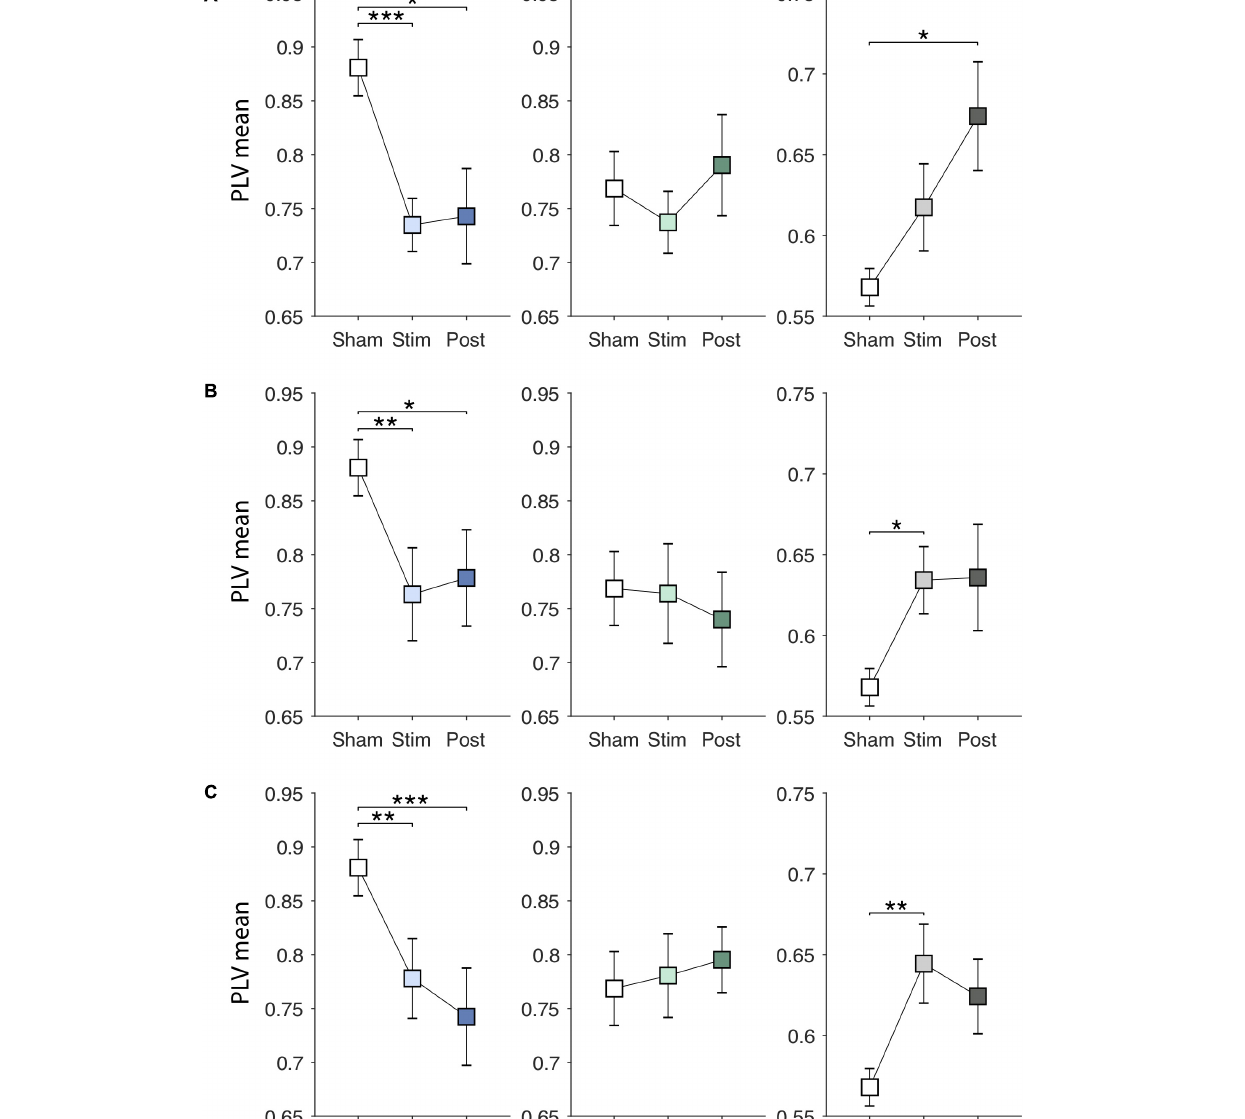
motor cortical regions (Brown, 2007; Jenkinson and Brown,